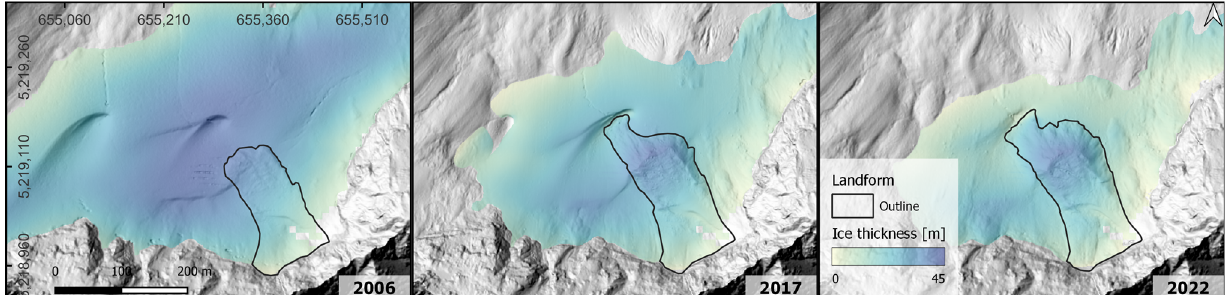
Figure 3. ( a ) Mean annual surface elevation change in the landform and the surrounding glacier. ( b ) Mean elevation in the transverse and longitudinal swath profiles (50 m), represents the mean change in the shape of the landform. The locations of the profiles are shown in Figure 3a.